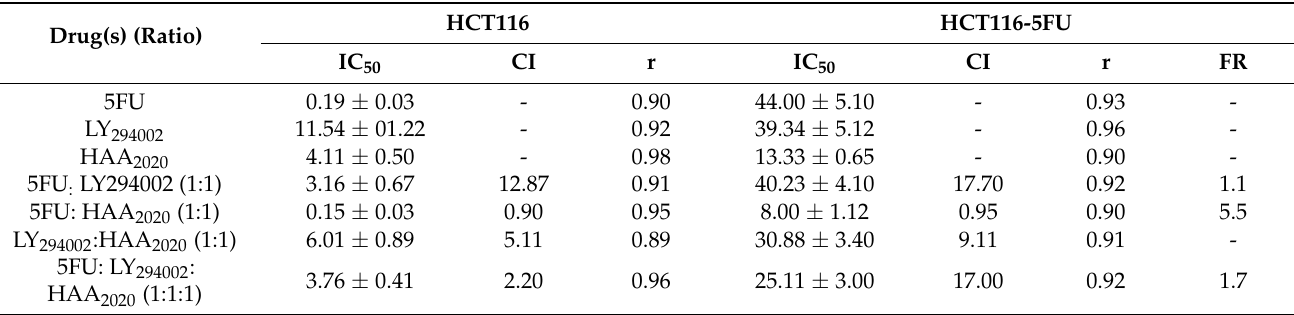
Table 4. IC 50 values (72 h mean ± SD, µ M), combination index and fold reversal of 5FU, LY294002, HAA 2020 , and their combinations in HCT116 and HCT116-5FU